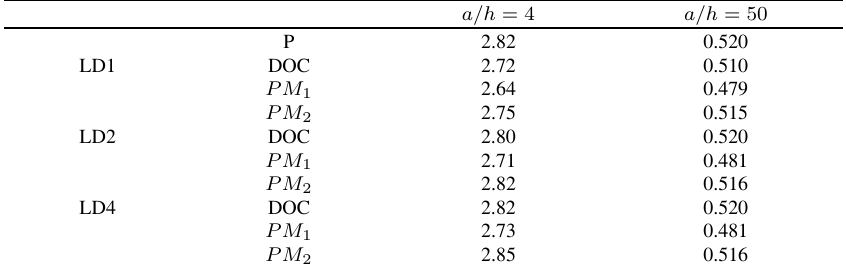
Table 3 u z ( a 2 , b 2 , 0) for a SSSS plate. PLATE-11, a = 3 b , q 0 = 10[ MPa ] . P = [24]; DOC = [25]; PM 1